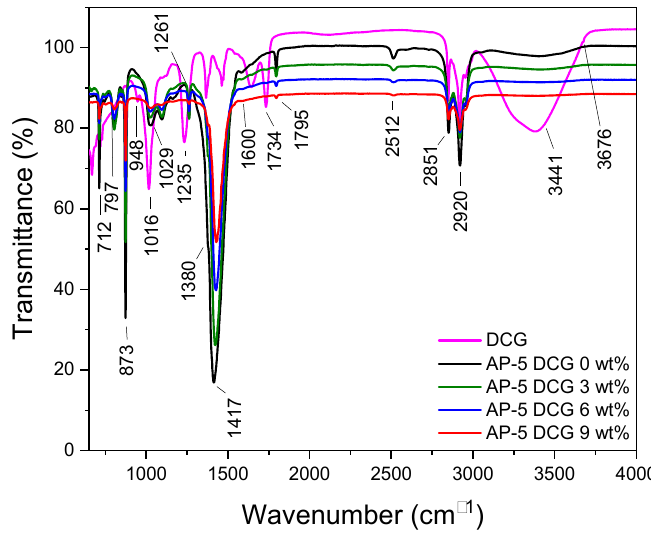
Figure 2. FT-IR spectra of fresh DCG, base AP-5 asphalt, and its specimens loaded with various fractions of DCG (e.g., 3, 6, and 9 wt%).